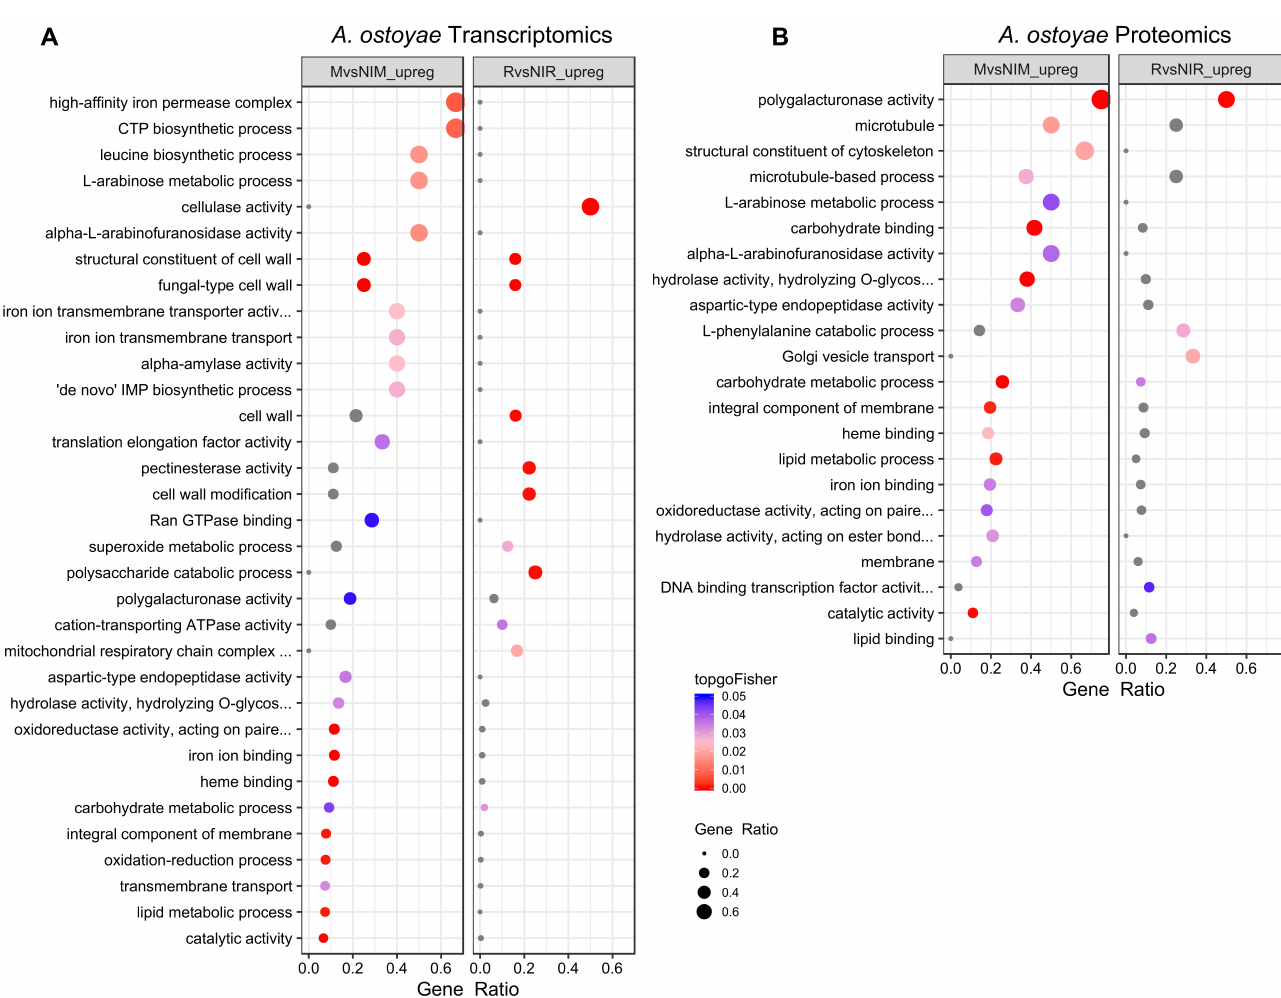
Figure 2. Enriched GO terms in M vs NIM and R vs NIR of A. ostoyae for transcriptomics ( A ) and proteomics ( B ). The ratio of number of a particular GO term in a specific comparison (mycelium vs. non-invasive mycelium or in rhizomorphs vs non-invasive rhizomorphs) to the total number of that GO term for a species was used to plot gene ratios for enriched GO terms ( p < 0.05, Fisher’s exact test). The size of the dot is directly proportional to gene ratio, and the color of the dots corresponds to p -values. Grey dots represent GO terms, enriched in only one of the comparisons i.e. either mycelium vs. non-invasive mycelium or rhizomorphs vs. non-invasive rhizomorphs. Enriched GO terms in M vs NIM and R vs NIR of A. cepistipes can be found in Supplementary Figure